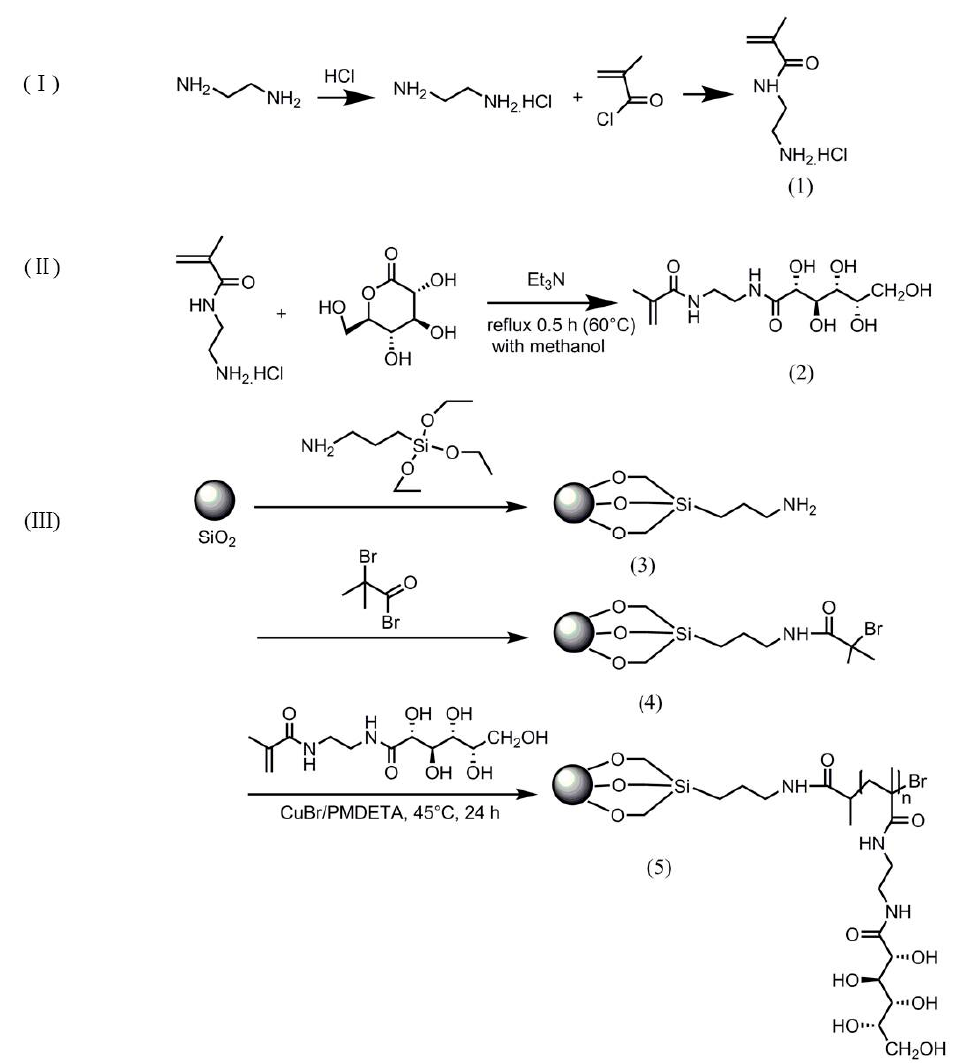
Scheme 2. Synthesis steps for the preparation of SiO 2